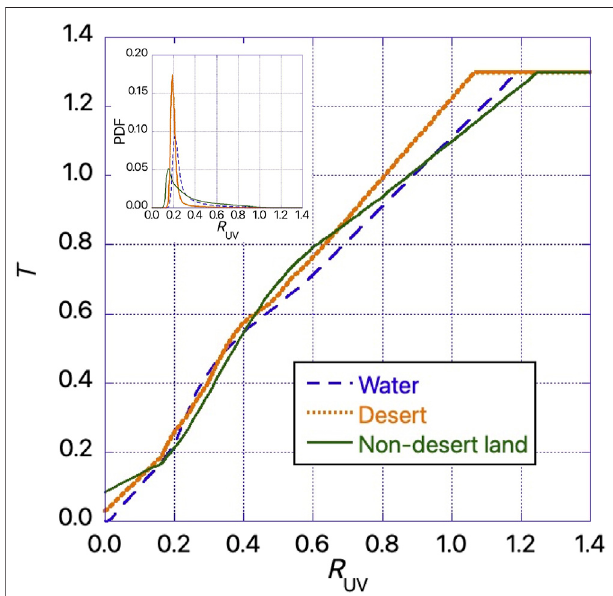
FIGURE 2 | Threshold values used in the detection of blue glints. Pixels are fl agged as glint if their blue re fl ectance exceeds the T threshold value for the pixel ’ s 388 nm re fl ectance R UV . The inset shows the PDFs of R UV for the three surface types, indicating that the most frequently used threshold values occur at moderate R UV